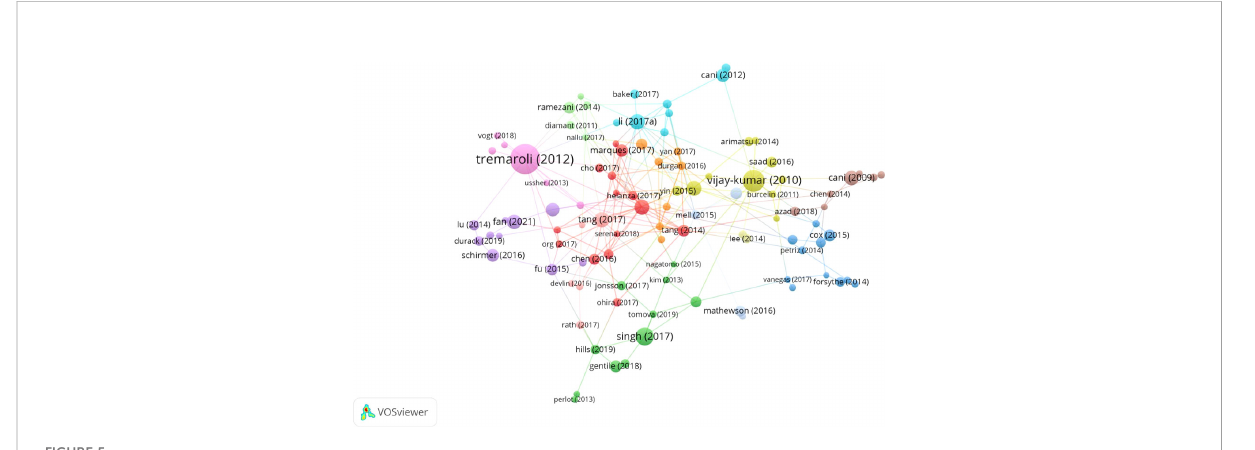
FIGURE 5 Bibliographic analysis of 115 publications with more than 120 citations.